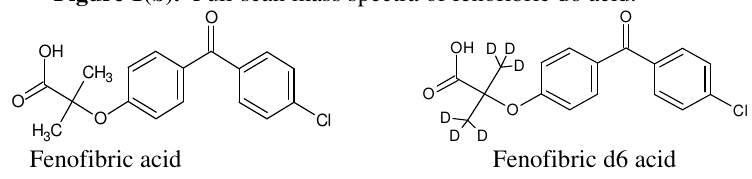
Figure 1(b). Full-scan mass spectra of fenofibric d6 acid.